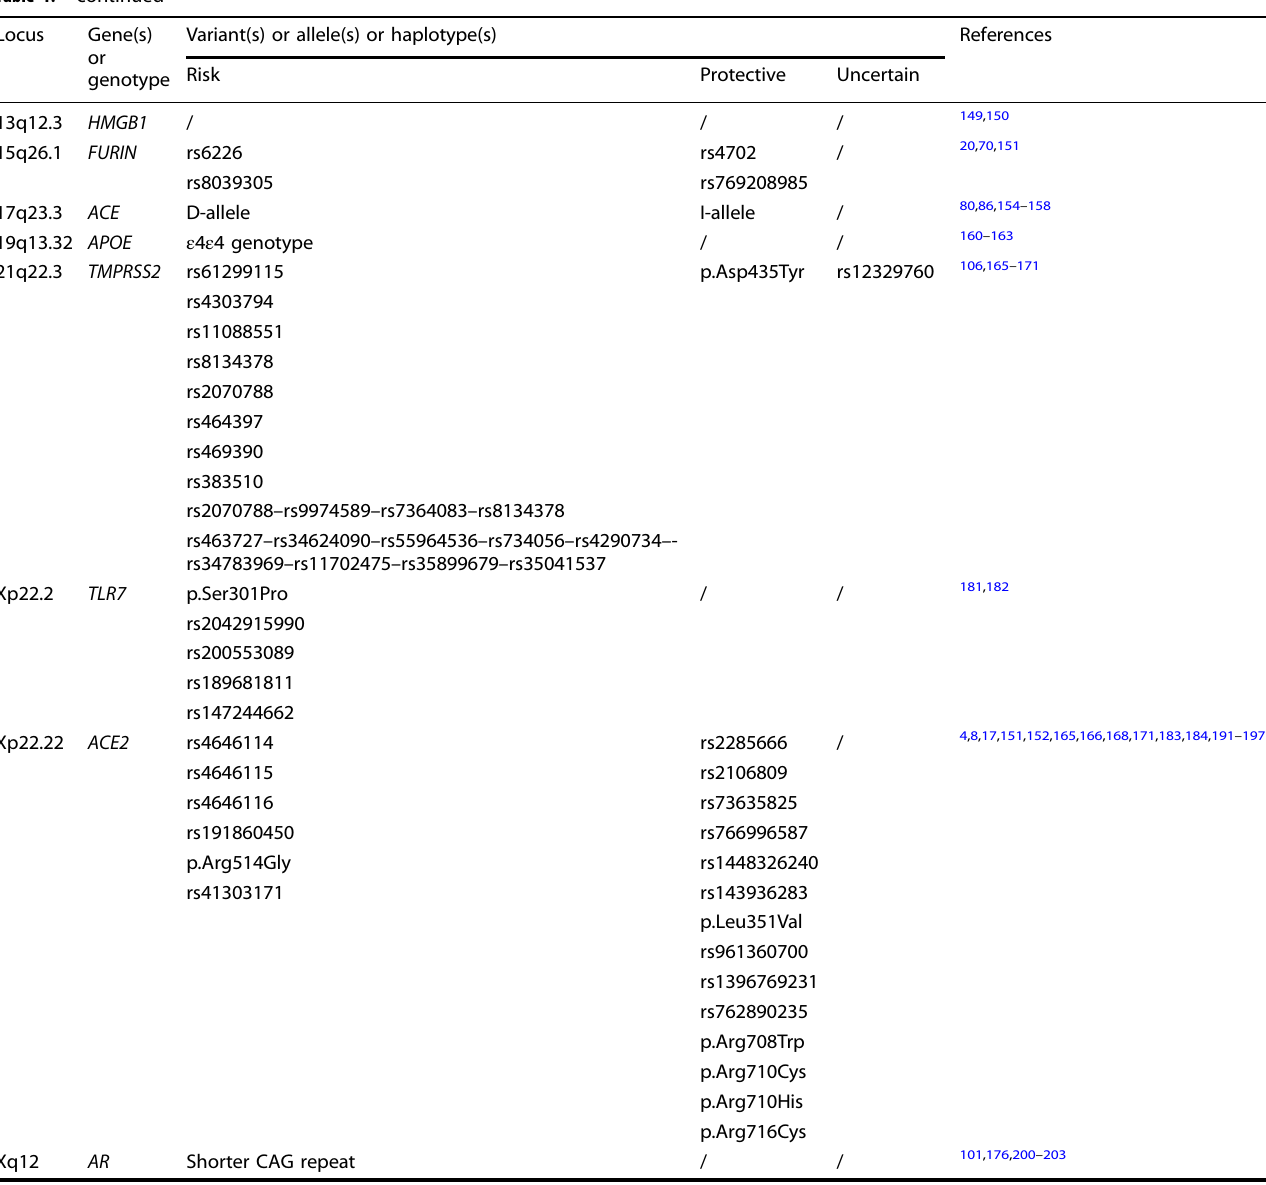
consolidation ( ∼ 27.7 – 73.5%), bronchial